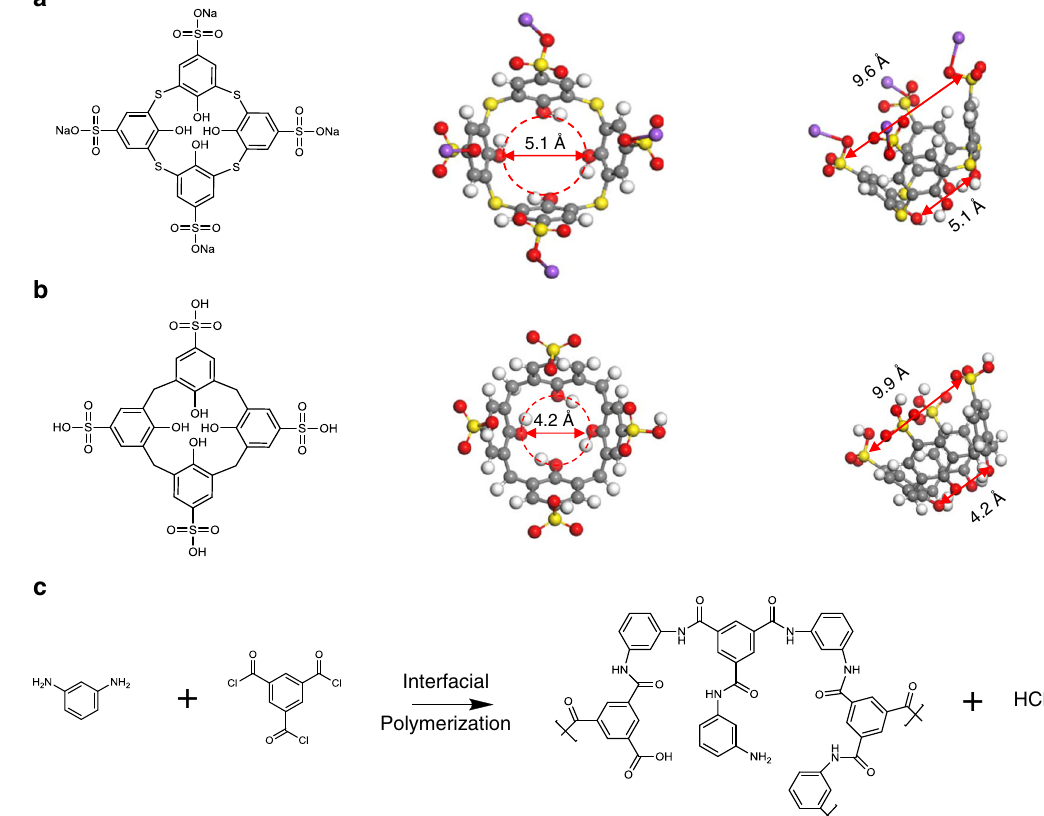
Fig. 1 Molecular structures and reaction scheme. Molecular structures of a STCAss, b SCA, and c interfacial polymerization between MPD (aqueous phase) and TMC (oil